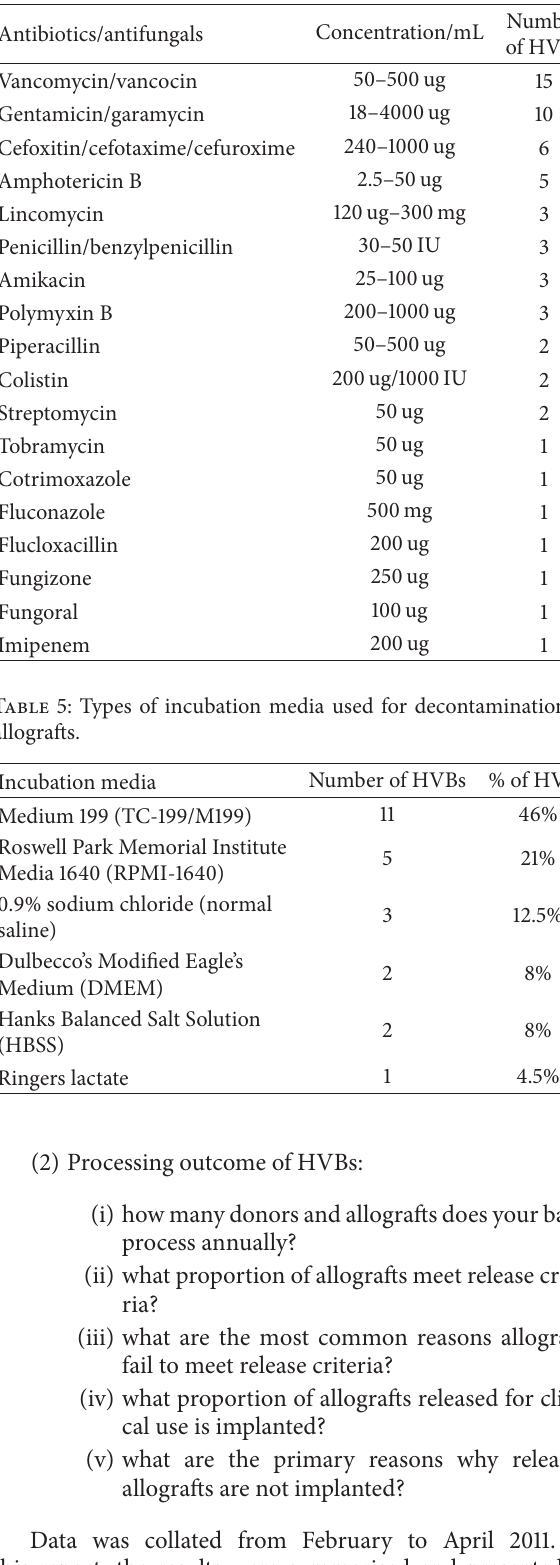
Table4:Typesandconcentrationsofantibioticsusedfordecontam- ination of allografts.